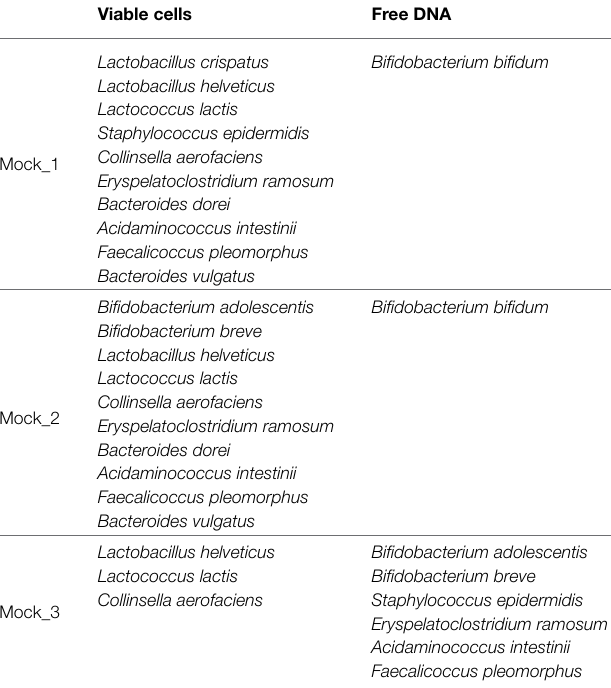
TABLE 1 | Bacterial composition of mock communities. Viable